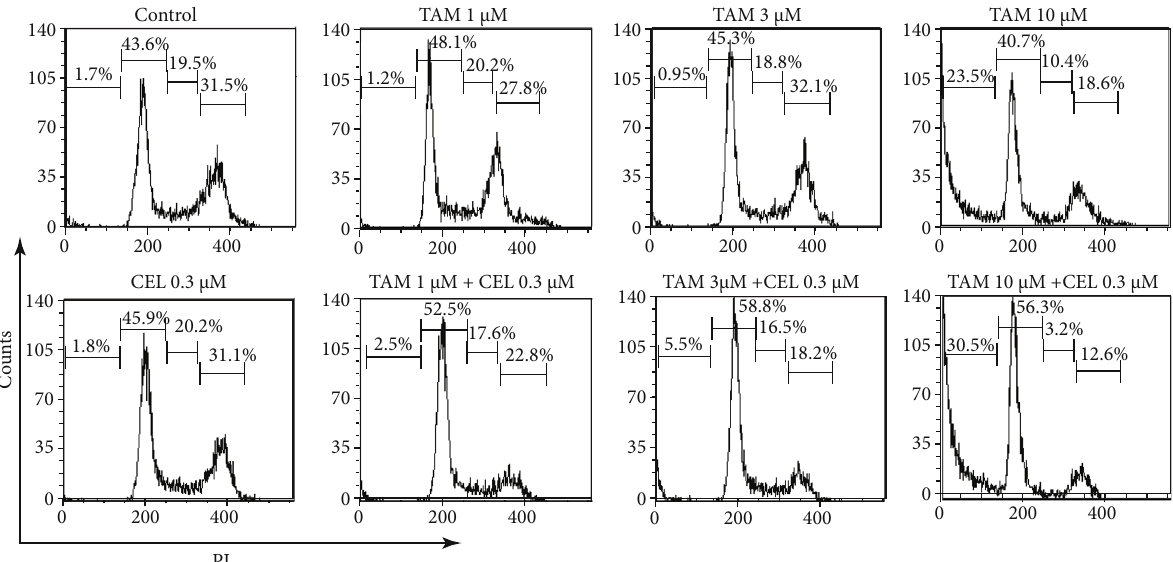
Figure 4: E ff ects of tamoxifen, celastrol, and tamoxifen and celastrol combinations on the cell cycle in MCF-7 cells. After treatment with the combination of tamoxifen and celastrol, the proportion of cells in the G1 phase was signi fi cantly increased compared with that of the control group, while the proportion of S phase and G2/M phase cells was